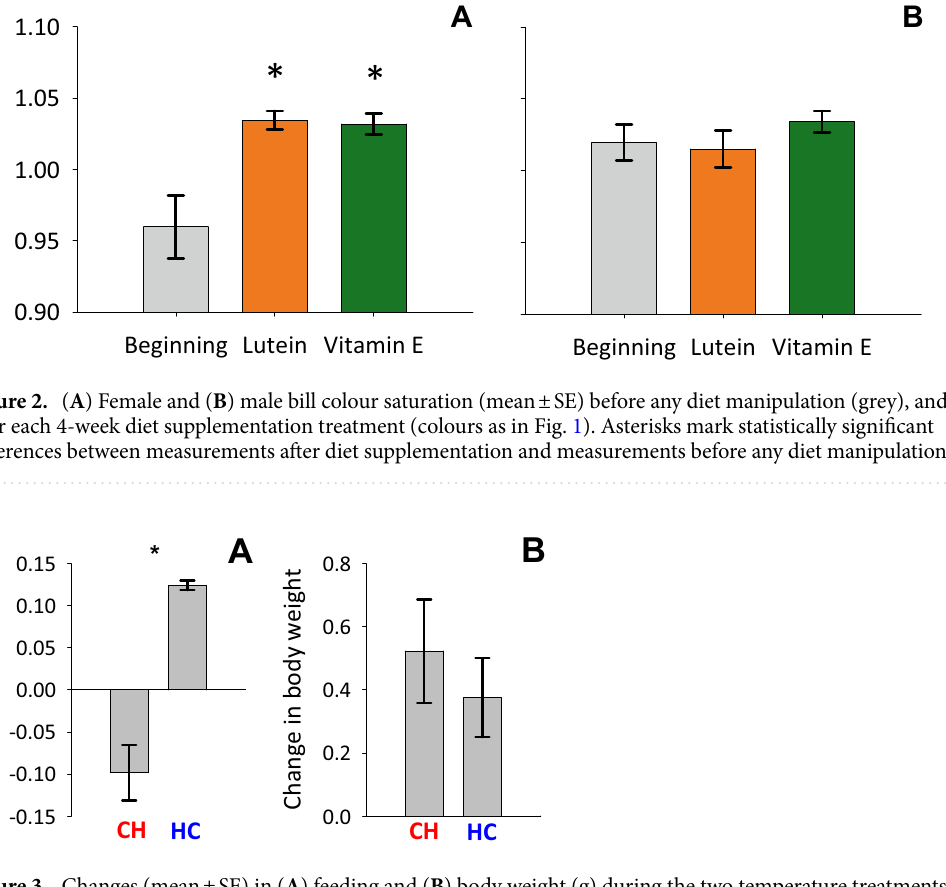
Figure 3. Changes (mean ± SE) in ( A ) feeding and ( B ) body weight (g) during the two temperature treatments. CH cold–hot treatment, HC hot–cold treatment. Asterisks mark statistically significant